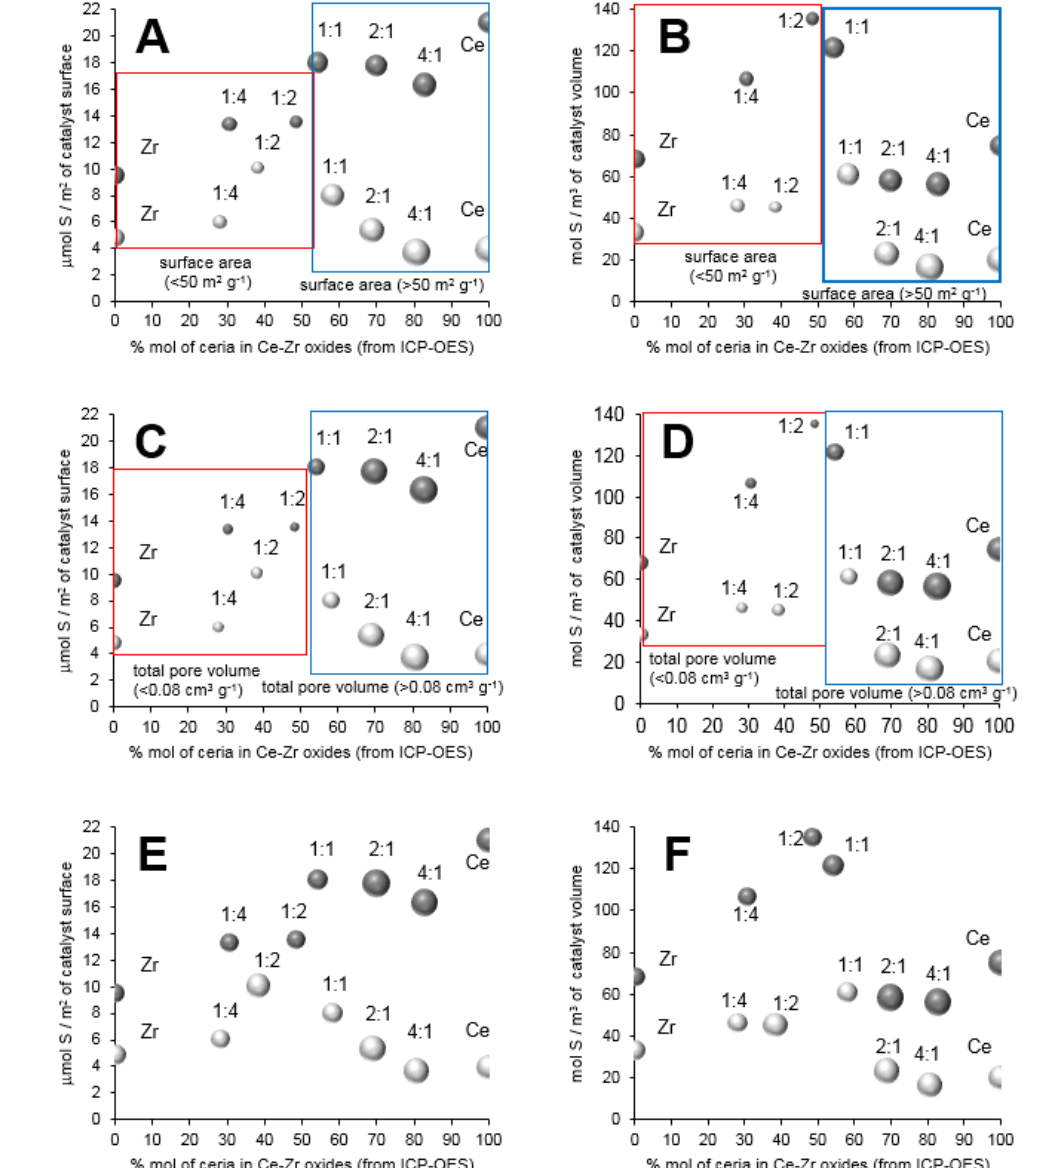
Figure 5. The correlation between sulfur content (as µ mol m − 2 of catalyst surface or mol m − 3 of catalyst volume) and the contents of metals in oxides (as % mol of ceria in Ce-Zr oxides estimated using ICP-OES, when was assumed that 100% of Ce was in the form of CeO 2 ) for selected surface parameters (( A , B ) for surface area, ( C , D ) for total pore volume, ( E , F ) for average pore size). The size of points is correlated to the values of the surface parameters. Dark points are described to the catalysts modified with sulfur and light points are due to the catalyst with sulfur and gold species and the ratios mean the nominal molar ratio CeO 2 :ZrO 2 of supports, Ce, Zr stand for CeO 2 , ZrO 2 , respectively.